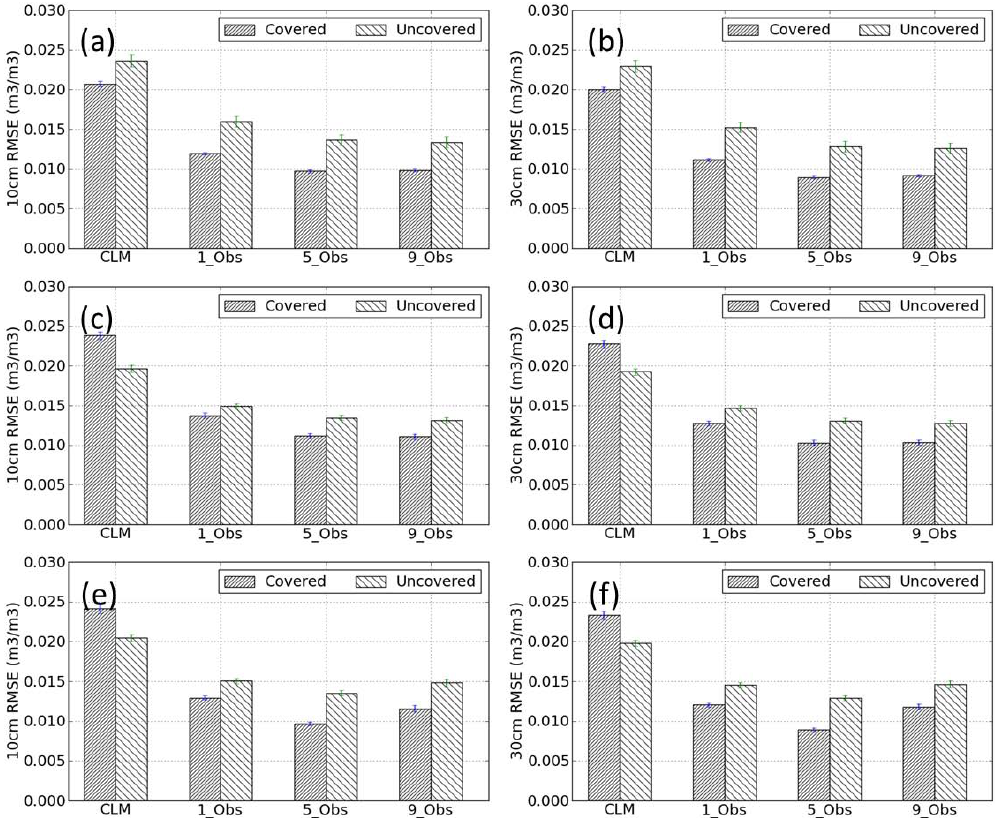
Fig. 3. Mean RMSE values of soil moisture (including 95% confidence intervals) for open loop simulations (CLM) and three assimilation strategies of 1 observation used (1 Obs), 5 observations used (5 Obs) and 9 observations used (9 Obs) for 10cm and 30cm depth. Results are shown for 70% – 10cm (a) , 30cm (b) – 47% – 10cm (c) , 30cm (d) – and 31% – 10cm (e) , 30cm (f) – observational